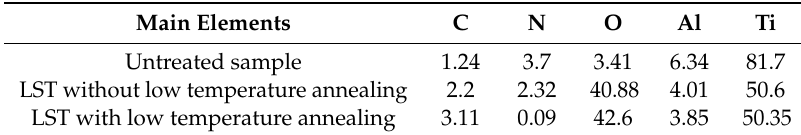
Figure 12. EDX energy spectrum of samples. ( a ) Untreated sample; ( b ) LST with low-temperature annealing; ( c ) LST without low-temperature annealing. Table 2. Element composition of untreated sample and LST surface with or without low-temperature annealing (wt %).